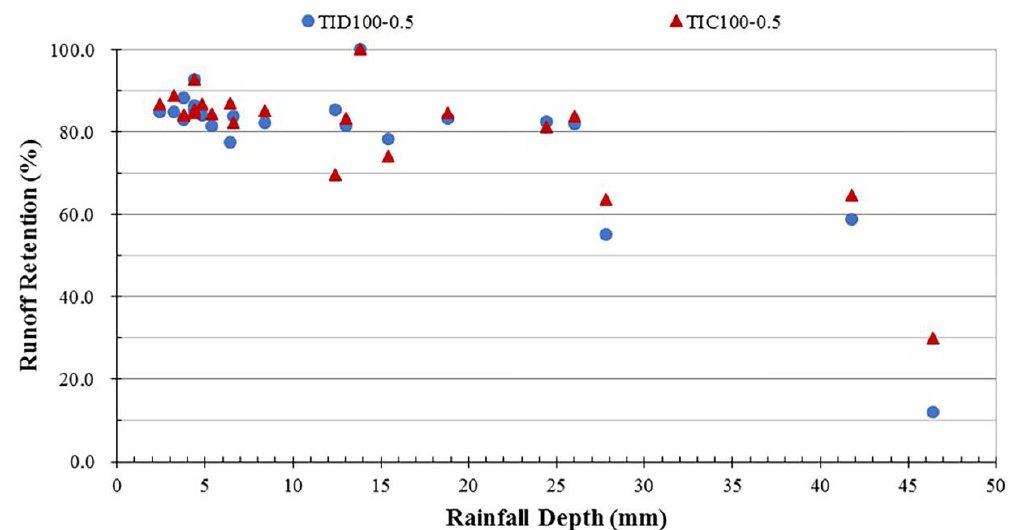
Figure 6. Rainfall retention rates R3 varying with different drainage layer types of EGR modules under 22 monitored rainfall events.